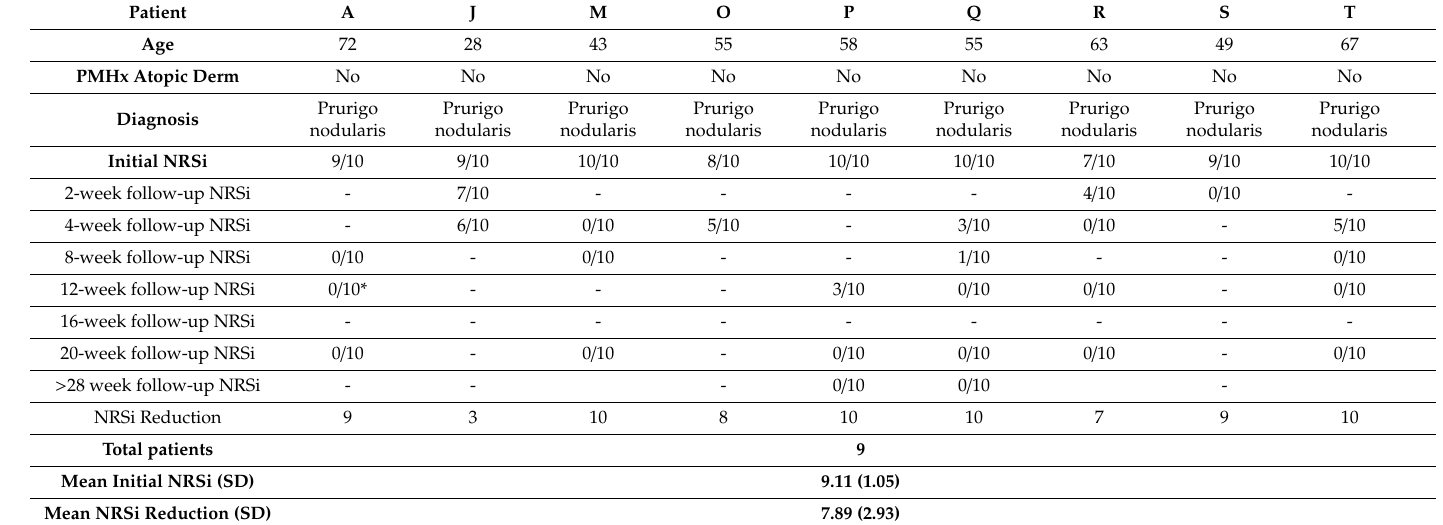
Table 2. Prurigo